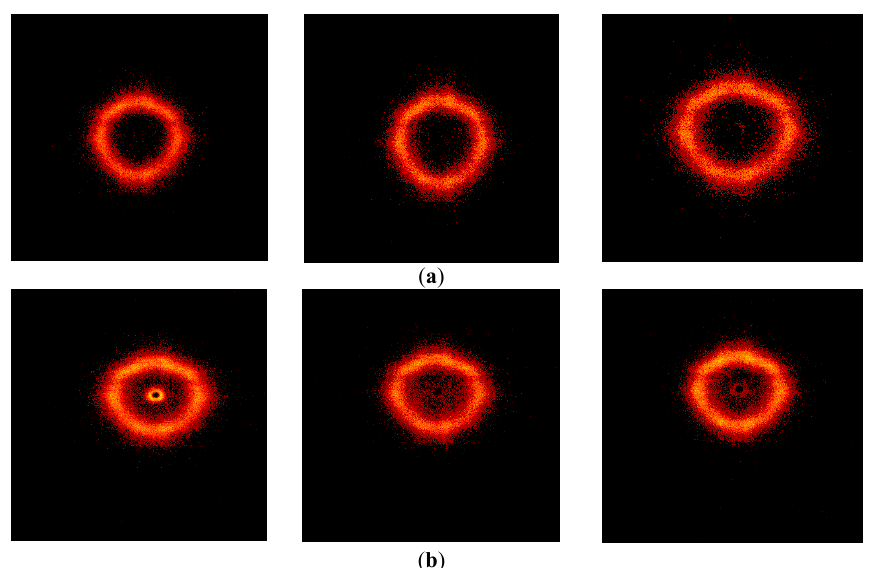
Figure 13. Screenshots of the 2-D SAXS patterns of POI-Gl-POSS-0.1 ( a ) and POI-Gl-POSS-15 ( b ), obtained before swelling, after swelling in water, and after 2 days at room temperature (dried). The acquisition time for each experiment is 1000 s. data acquisition time for each experiment is 1000 s.